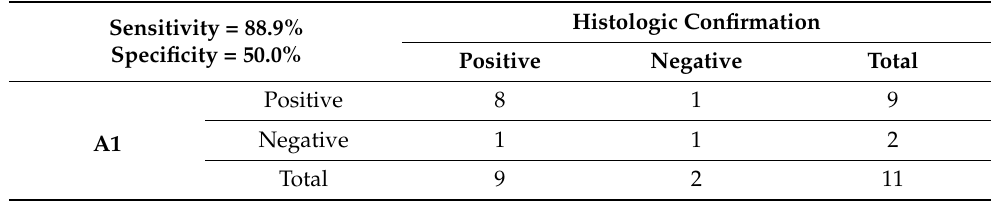
Table 11. Sensitivity and specificity of 68 Ga-PSMA-PET/CT A1 with histologic confirmation. Sensitivity =